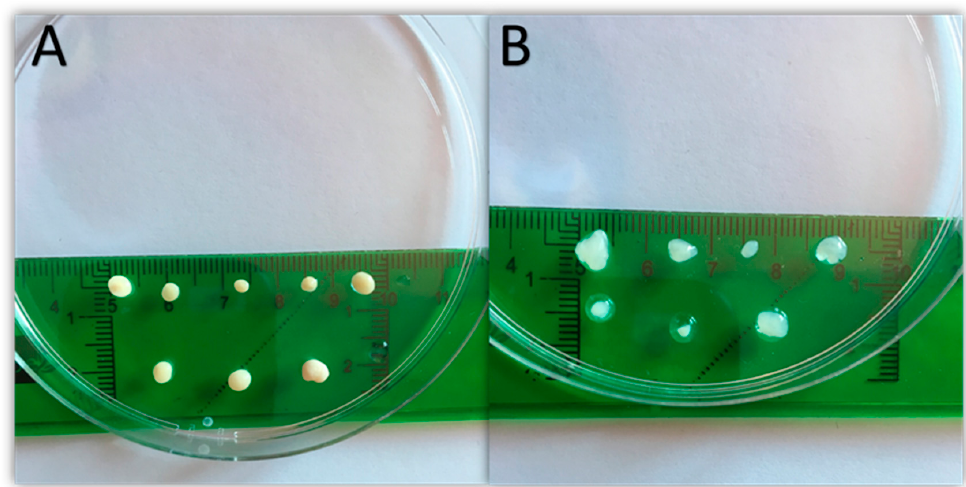
Figure 3. ( A ) Granules of Pseudomonas stutzeri at operational day 40; ( B ) granules of Pseudomonas fluorescens PSC26 at operational day 40.